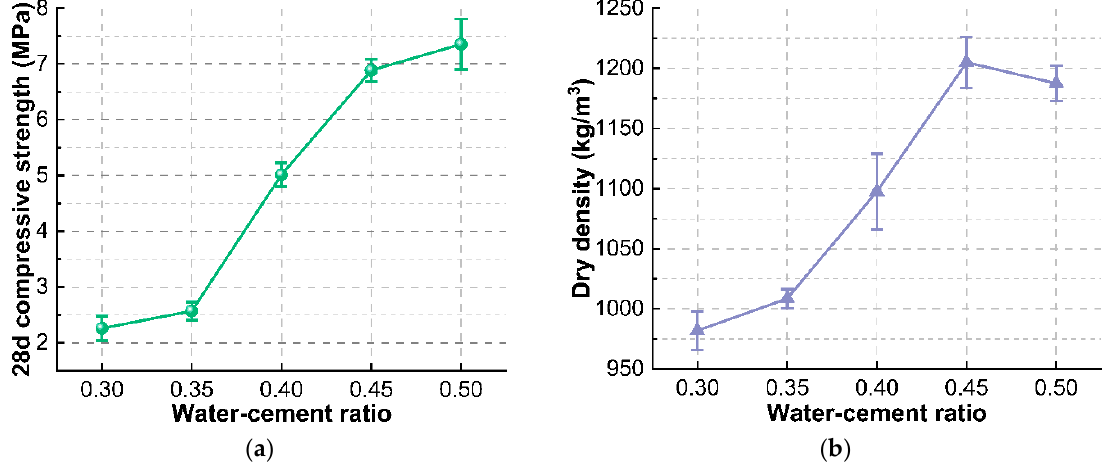
Figure 8. Effect of water-cement ratio on ( a ) 28 d compressive strength and ( b ) dry density of foam concrete.